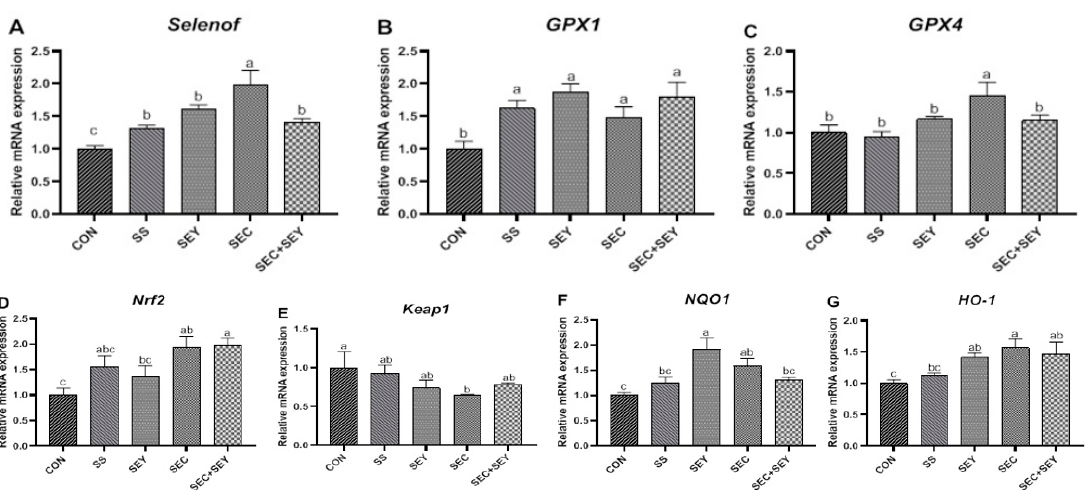
Figure 3. Relative mRNA expression of selenoprotein ( A – C ) and Nrf2/Keap1 pathway genes ( D – G ) in the ovaries of laying hens fed different Se sources. Data are means of 6 replicates per dietary treatment. Bars with different letters (a–c) indicate a significant difference ( p < 0.05). Selenof, selenoprotein f; GPX1, glutathione peroxidase 1; GPX4, glutathione peroxidase 4; Nrf2, nuclear factor erythroid 2-related factor 2; Keap1, Kelch-like ECH-associated protein 1; NQO1, NAD(P)H quinone dehydrogenase 1; HO-1, heme oxygenase 1.